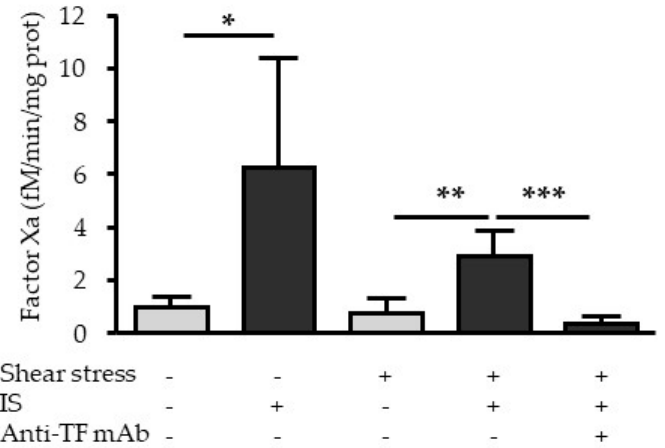
Figure 7. Effect of shear stress and IS on TF procoagulant activity. HUVEC were subjected to shear stress (5 dynes / cm2) and / or IS (200 µ M) during 6 h, and TF-dependent procoagulant activity was studied by measuring the generation of factor Xa. A blocking TF antibody was used to confirm that factor Xa generation was dependent on TF. Data, expressed in fM / min / mg protein of factor Xa, represent the mean ± SEM of n = 7 independent experiments. * p < 0.05, ** p < 0.01, *** p < 0.001.